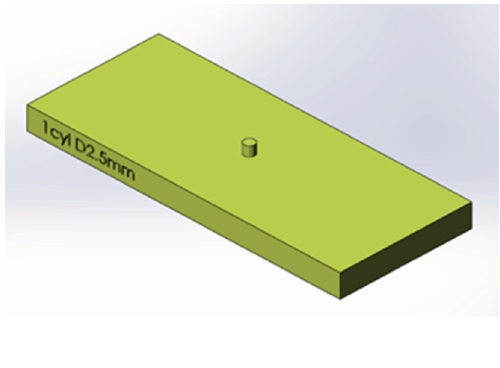
Figure 7. CAD drawing of the stimulus used in the tactile